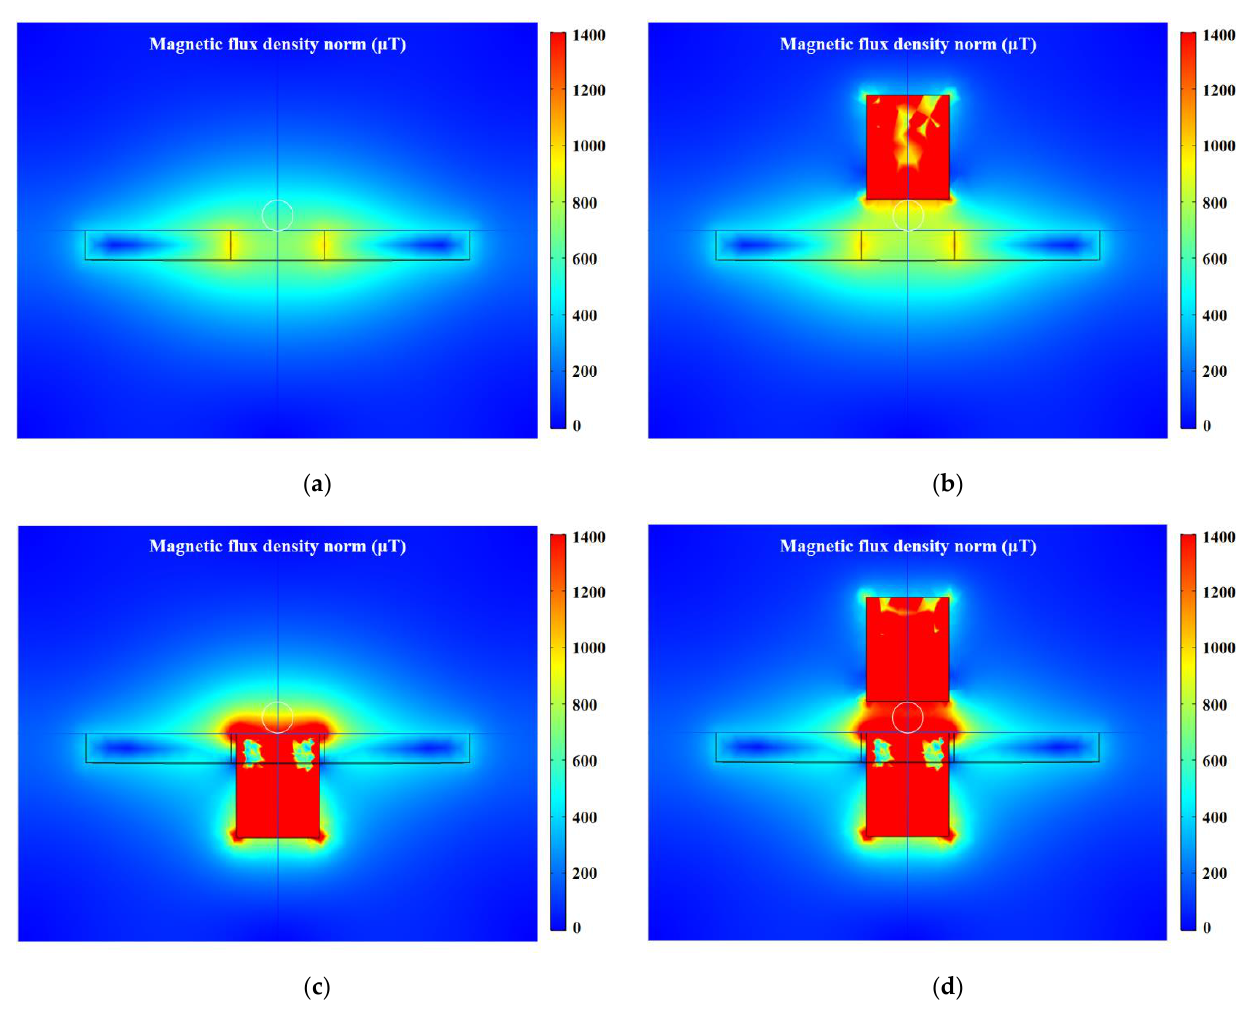
Figure 3. Distribution characteristics of magnetic field in detection region. ( a ) Magnetic field around coil. ( b ) Magnetic field around sensing unit with external silicon steel strip. ( c ) Magnetic field around sensing unit with built-in silicon steel strip. ( d ) Magnetic field around sensing unit with built-in and external silicon steel strips.